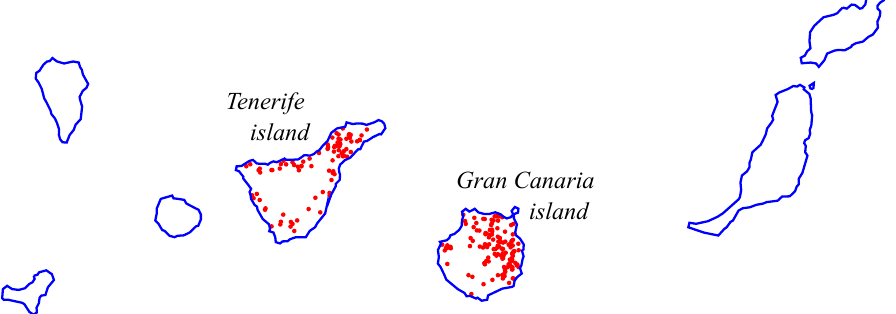
Figure 3. Location of the livestock farms of pigs of Tenerife and Gran Canaria